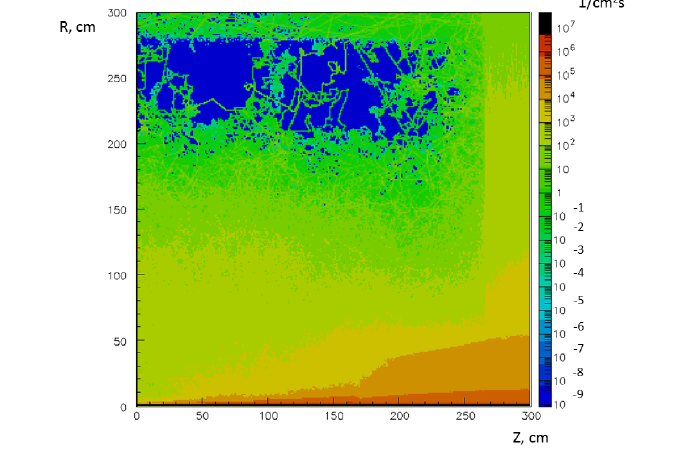
Figure 4. . 1-MeV neutron equivalent fluence for Si in particles / cm 2